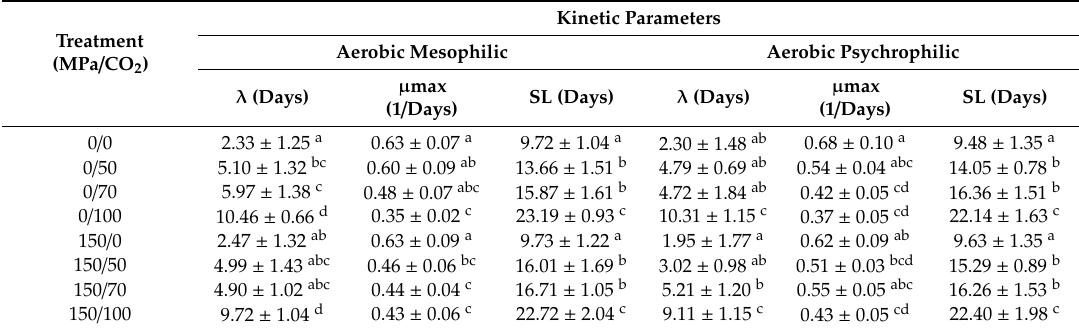
Table 6. E ff ect of treatment on initial counts of studied microbial populations (log CFU / g) in coho salmon fillets.